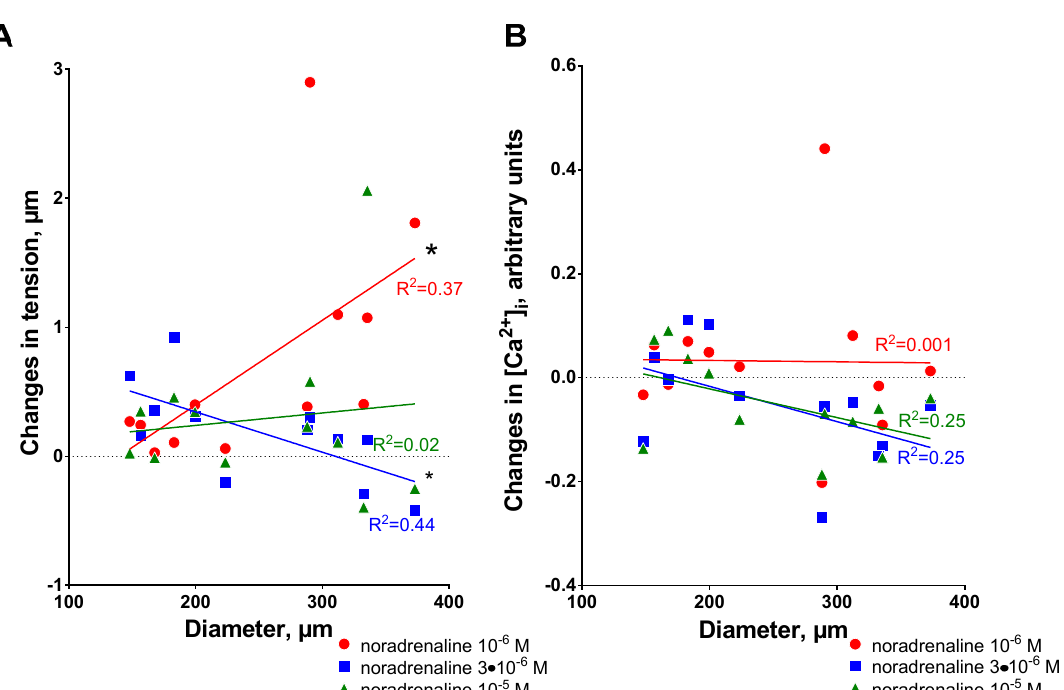
Figure 4. The potentiating effect of ouabain increases with arterial diameter for wall tension responses to 1 µM noradrenaline ( A ) but not for the changes in [Ca 2+ ] i ( B ). ( A ) shows the differences in wall tension increase to 1 µM (red), 3 µM (blue) and 10 µM (green) noradrenaline stimulations after incubation with 10 µM ouabain, the data are shown in Figure 2B. ( B ) demonstrates the corresponding differences in [Ca 2+ ] i changes after incubation with 10 µM ouabain, the data are shown in Figure 3B. Linear regression quantifies goodness of fit with R 2 , as indicated by the lines. * indicates significance of the correlation, where p < 0.05, n = 12.